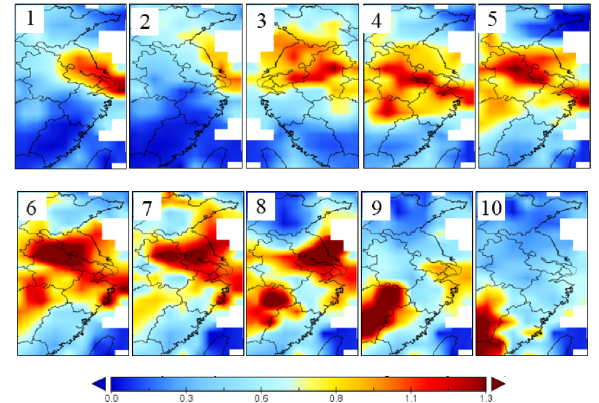
Figure 3. Aerosol optical depth (AOD) at 550nm from MODIS over the YRD region at 06:00 (UTC) from 1 to 10 December 2013 (http://modis.gsfc.nasa.gov/).